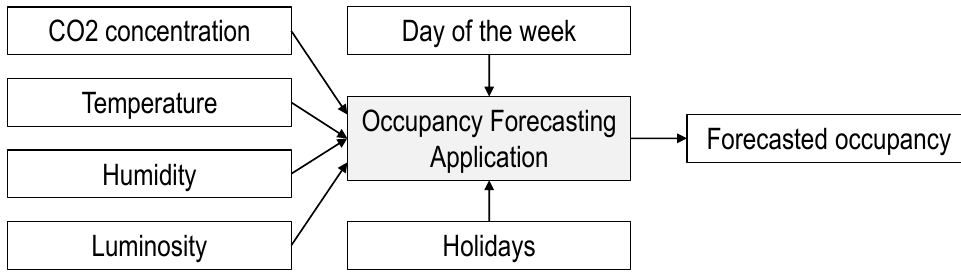
Figure 19. Block scheme of the occupancy forecasting application based on the unsupervised